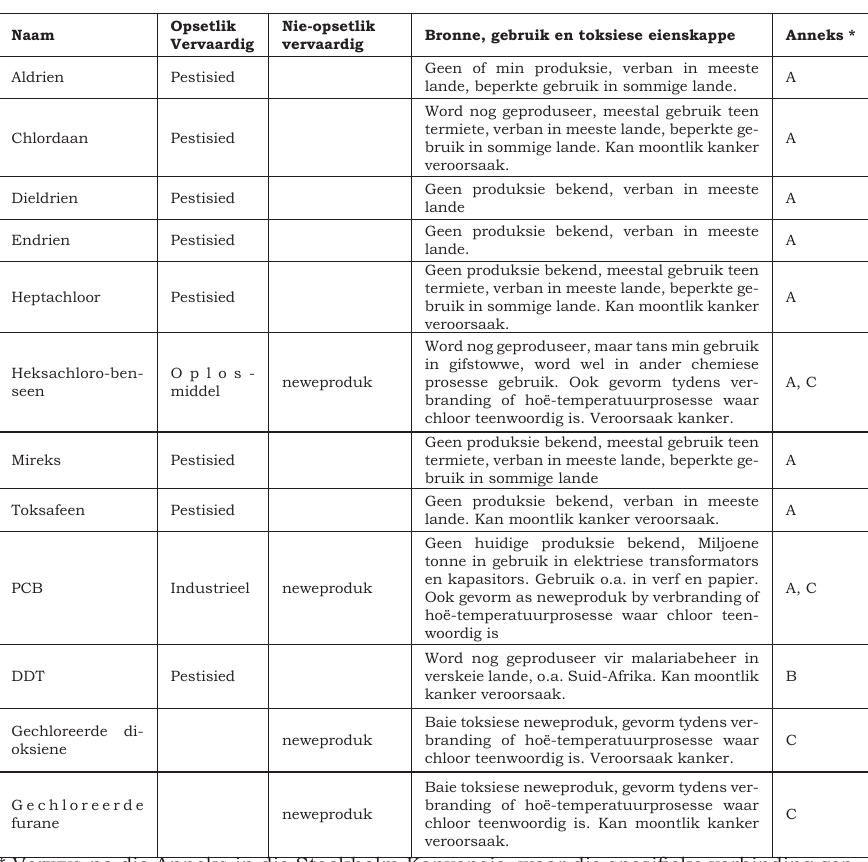
Gechloreerde di- oksiene